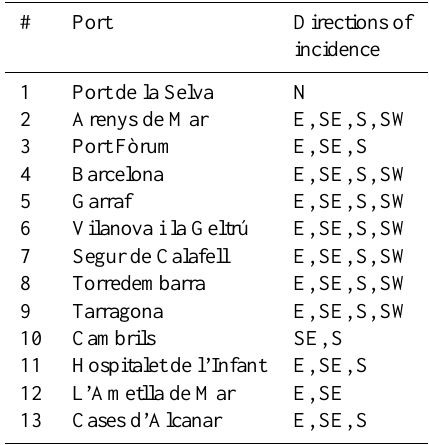
Table 1. Frequencies of occurrence for the used wave height in- tervals and wave direction sectors in front of the Barcelona port. Present conditions for model RCA_E.